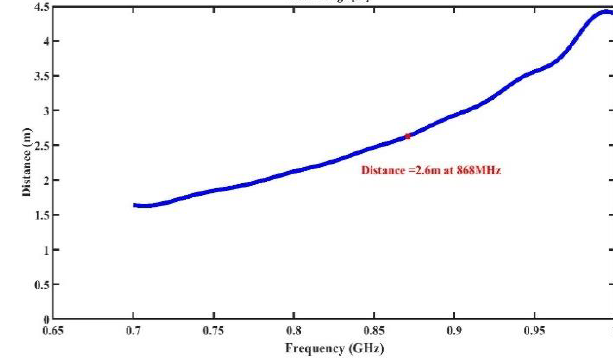
Fig.9. Simulated read range Vs Frequency /GHz of proposed RFID